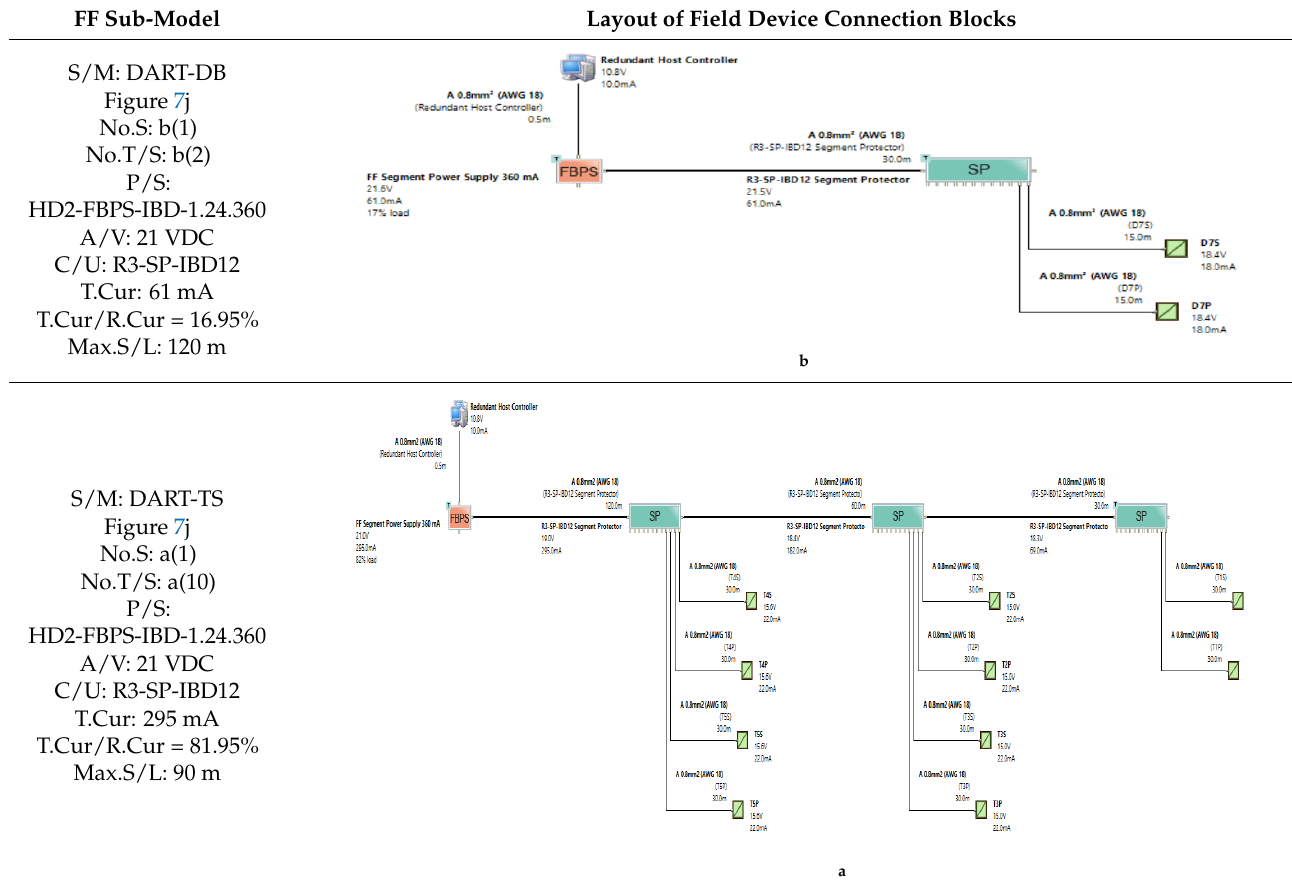
Table 1. Cont. Layout of Field Device Connection